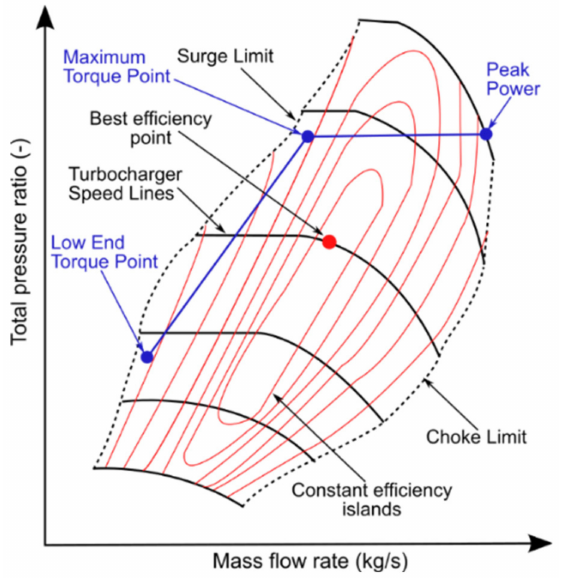
Figure 2. Compressor map overlaid with typical engine full load